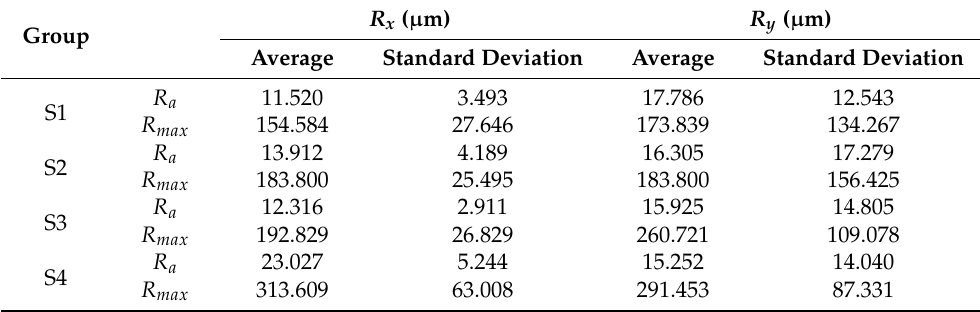
Table 2. Surface roughness in x- and y -directions of SLM AISI 420, built with various laser spot sizes. R x ( µ Group